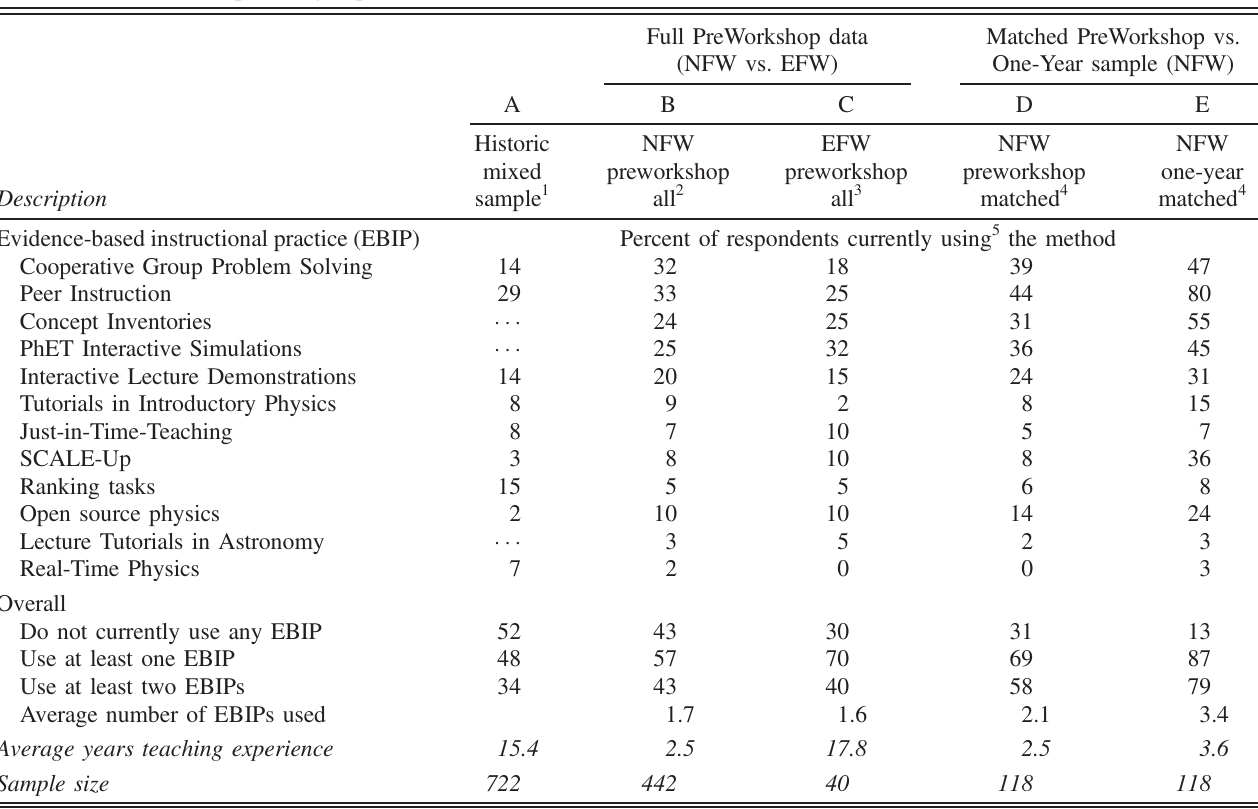
TABLE V. Current use of evidence-based instructional practices (EBIPs), by teaching experience, compared to historical data. See headers for relevant comparison